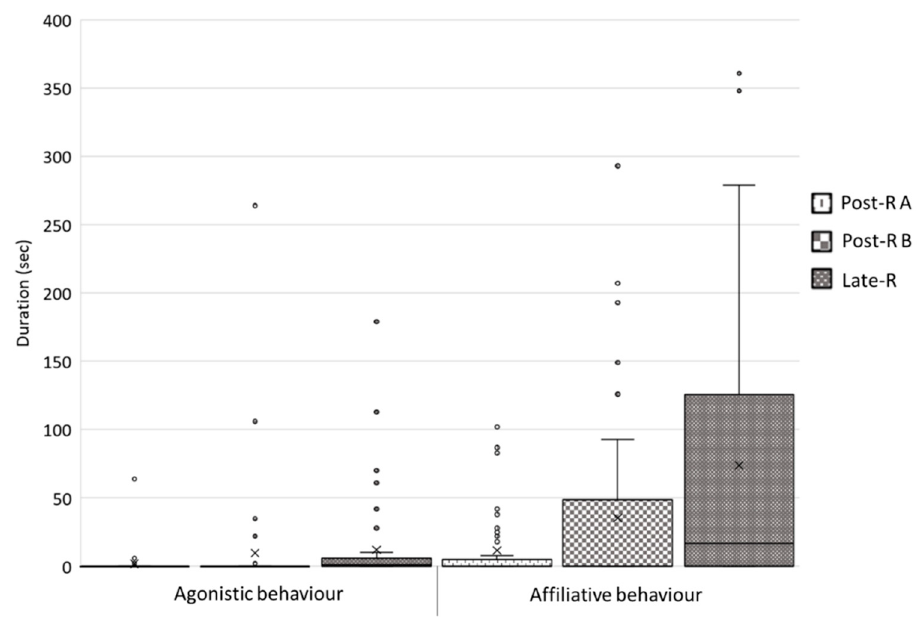
Figure 2. Box and whisker plot of the duration of agonistic and affiliative behaviours shown by wildcats during post-reunion period A (Post-R A), post-reunion period B (Post-R B) and the late- reunion period (Late-R). The horizontal lines within the box indicate the medians, boundaries of the box indicate the 25th and 75th percentile, and the whiskers indicate the minimum and maximum values of the data samples. Outliers are drawn as